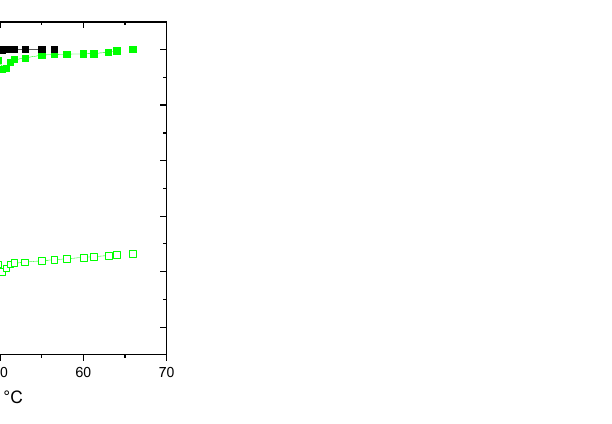
Figure 3. Temperature dependences of p -fraction as determined from the PDEAAm CH 2 signal and PAAm CH signal in the SN-D and DN-DA hydrogels.